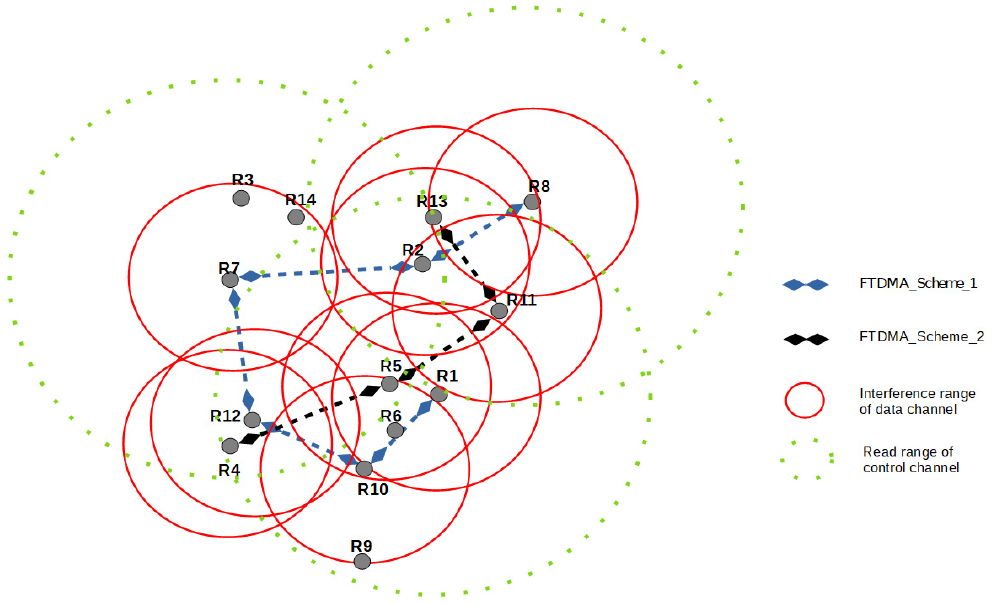
Figure 5. Application of the algorithm on an RFID network.